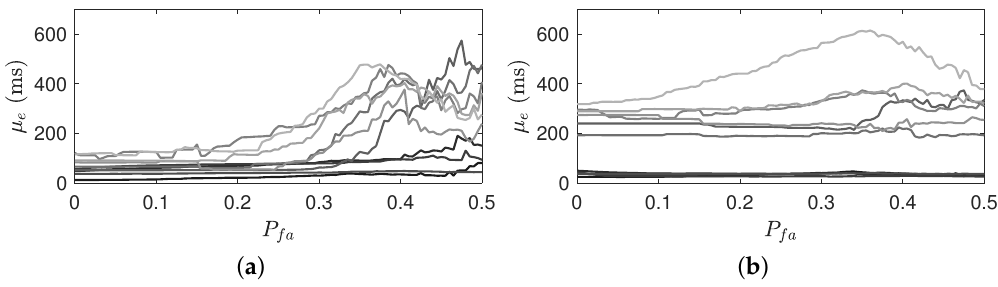
Figure 8. Estimated error variation related to P fa for 10 subjects. ( a ) Estimation error of onset detection. ( b ) Estimation error of offset